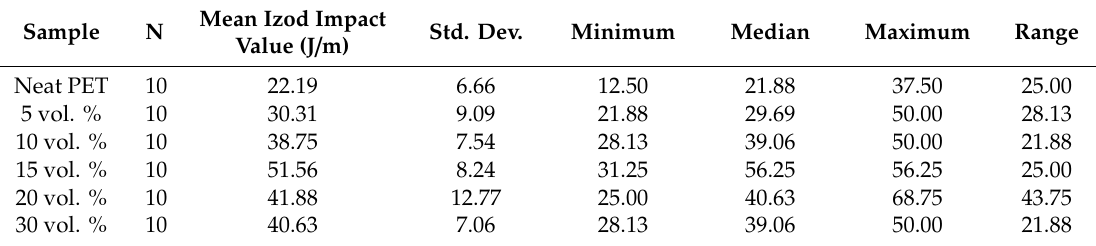
Table 7. Notched Izod Impact resistance in J / m of amorphous PET and Al 1 / amorphous PET composites. Std. Dev. is the standard deviation. N is number of